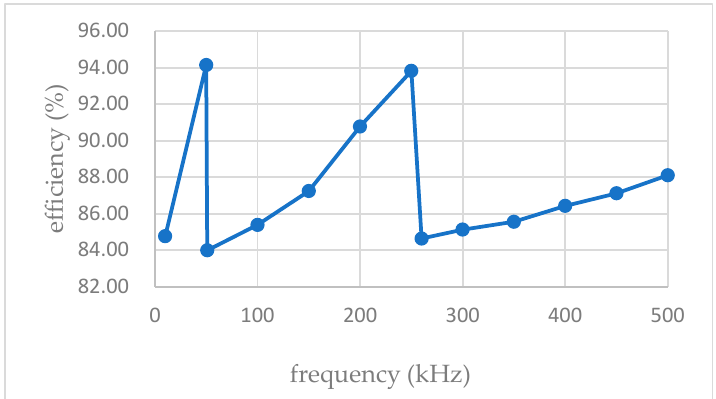
Figure 13. The efficiency of the inverter with variation in frequency.